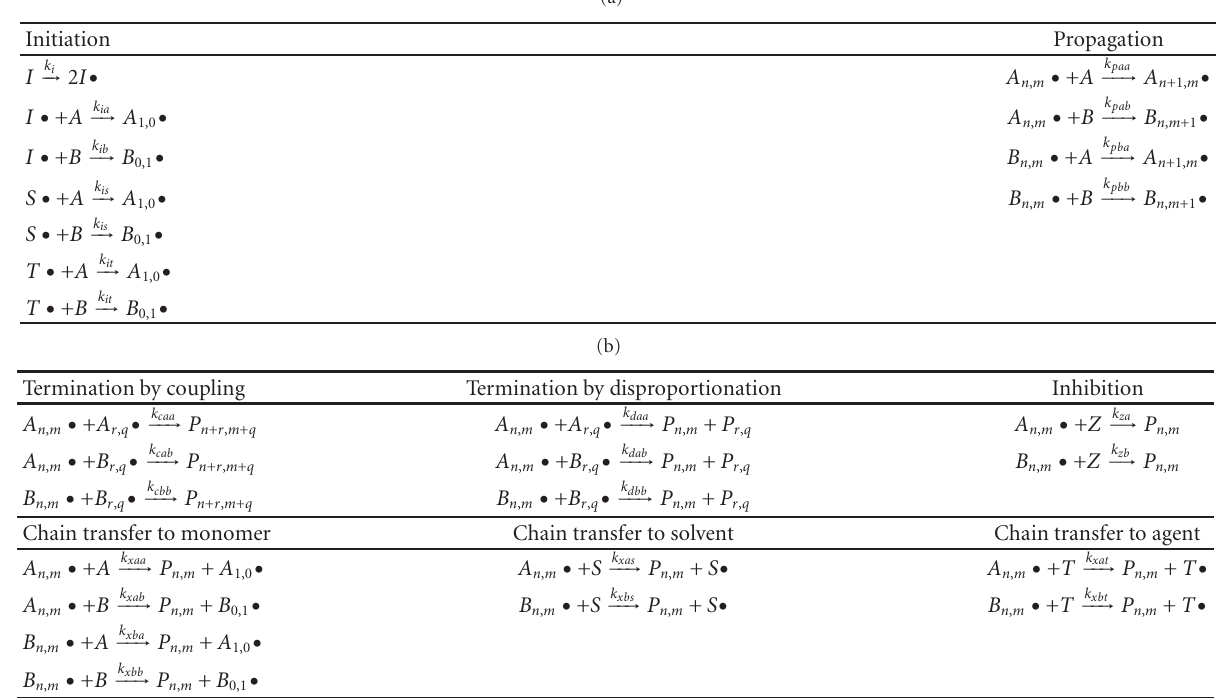
Table 7: Kinetic mechanism for deterministic